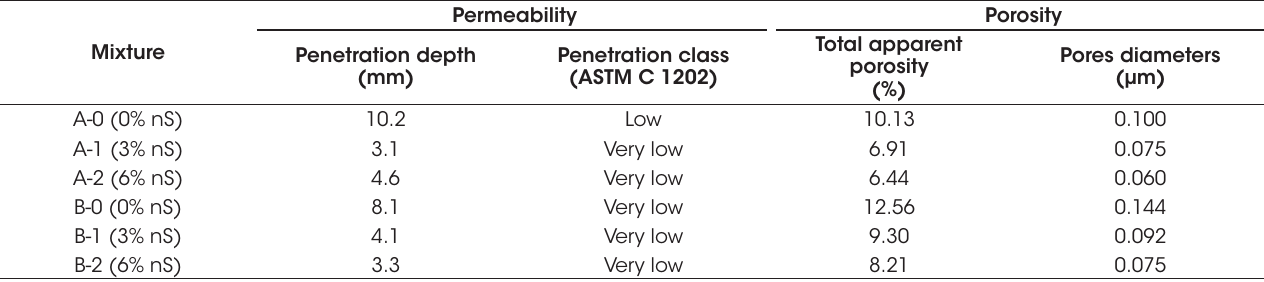
Permeability and porosity results of the concretes